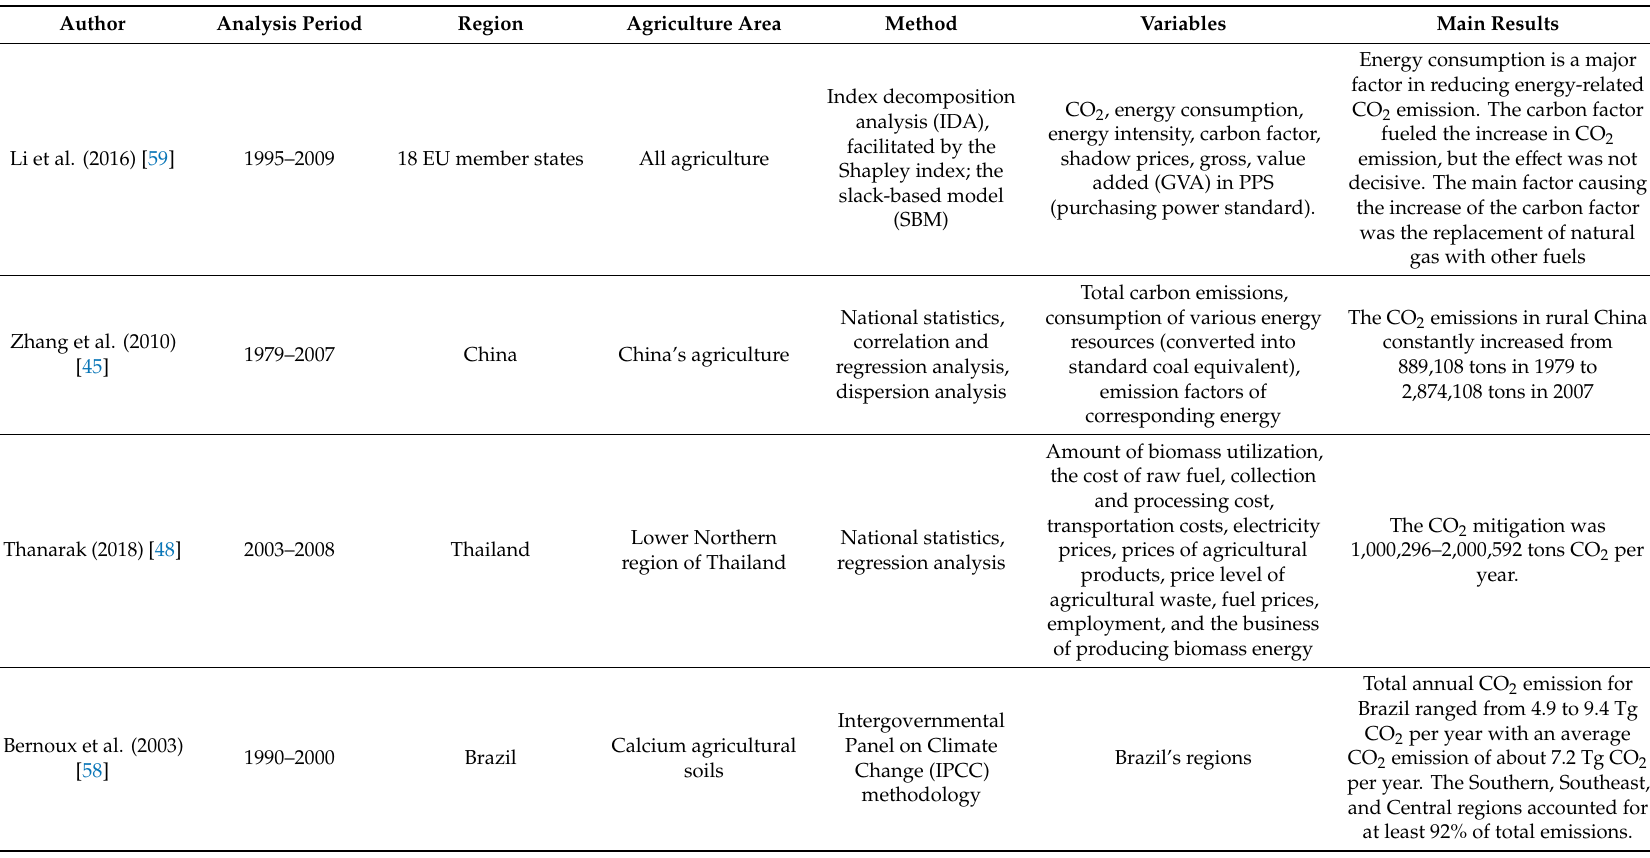
Table A1. Emissions of pollutants into the environment through